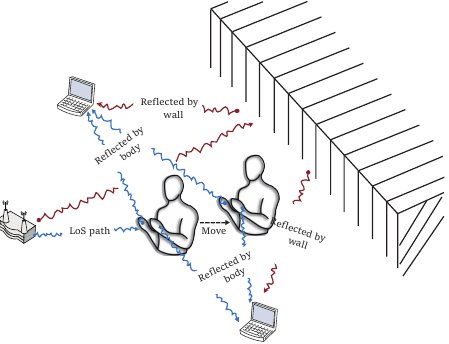
Figure 1. A WiFi signal propagates through multipath in reflected, refracted, and diffracted manners. For brief and clarity, only one way, the reflection, is shown in the illustration, where the red waves represent signals affected by moving torso and the blue waves represent signals affected by static